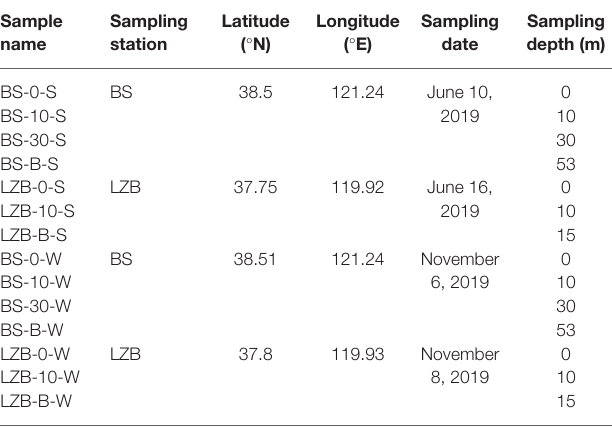
TABLE 1 | Information of sampling station, latitude, longitude, date, and depth of all